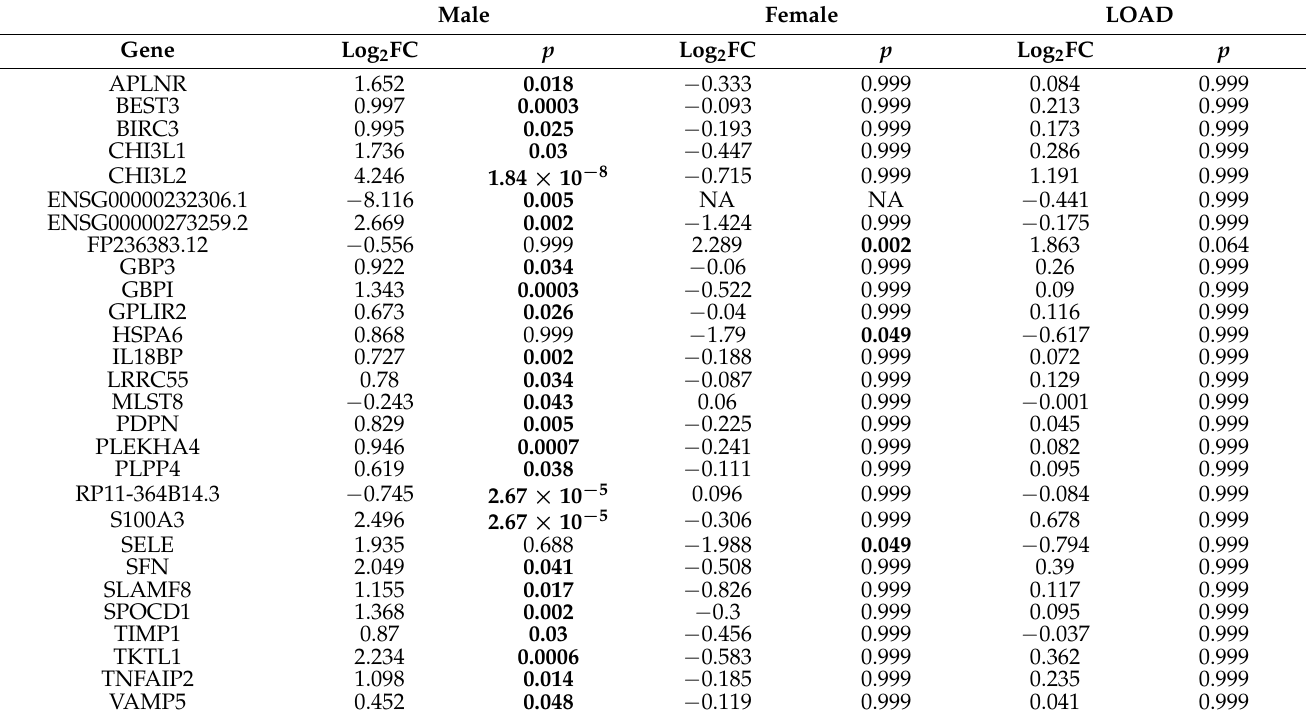
Table 2. Sex-Stratified LOAD Differential Expression Analysis Results. Male Female